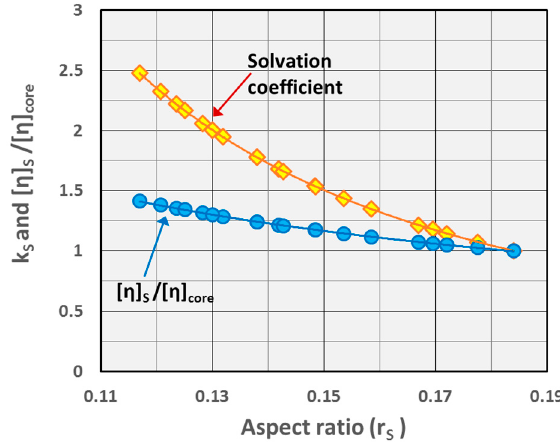
Figure 11. Variations of S k and CORES ][][ ηη with the aspect ratio S r .